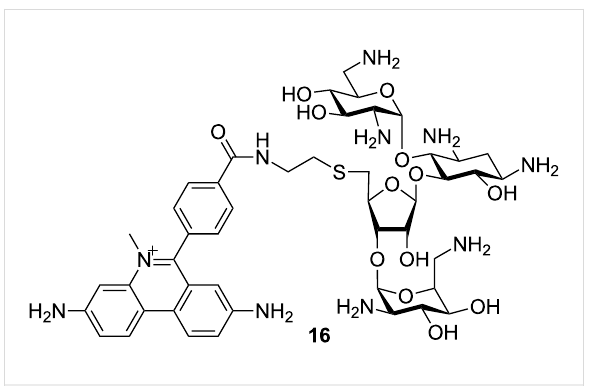
Laborious synthetic procedures for the preparation of bis-